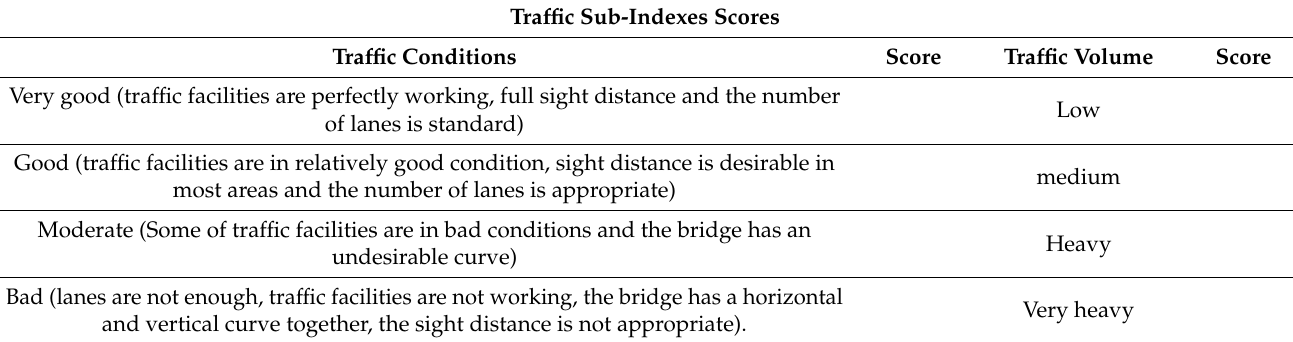
Table A10. Scores of traffic